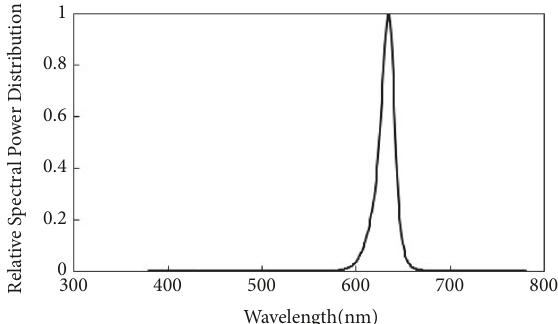
Figure 6: Spectral response of LED with a peak at 633.9